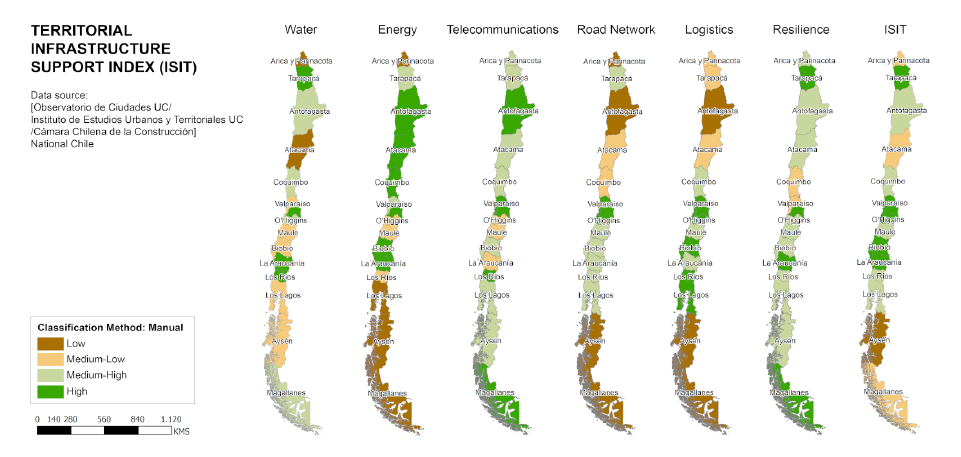
Figure 1: Interregional comparison by dimension of the